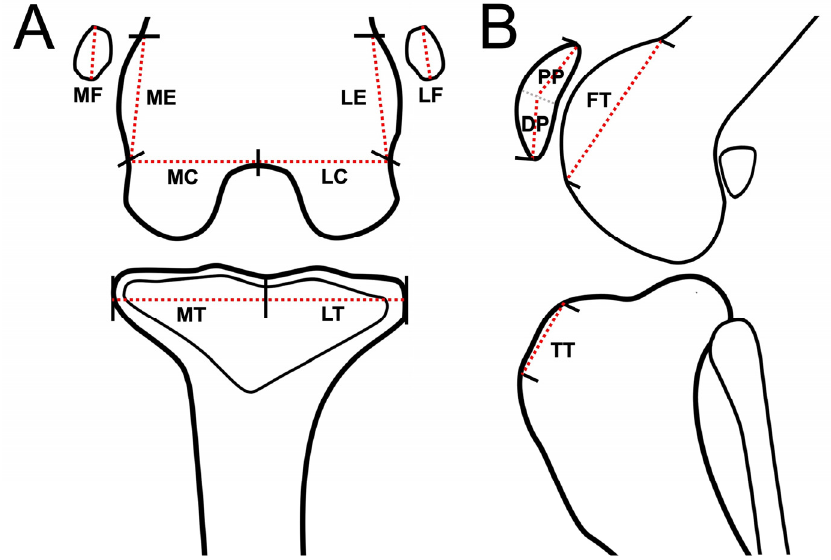
Figure 1. Schematic representation of stifle joint anatomic compartment subregions for evaluation of osteophytes/enthesophytes of each subregion, dorsal plane (MRI and CT) or caudocranial view (DR) ( A ), and sagittal plane (MRI and CT) or lateral view (DR) of stifle joint ( B ). Red dash lines are schematically represented as imaginary anatomic midline (AM) of the stifle joint for each subregion. Stifle joints are divided into 12 subregions for evaluating osteophytes/enthesophytes. Abbreviations: DP: distal patella; FT: femoral trochlear ridges; LC: lateral femoral condyle; LE: lateral femoral epicondyle; LF: lateral fabella; LT: lateral proximal tibia plateau to edge; MC: medial femoral condyle; ME: medial femoral epicondyle; MF: medial fabella; MT: medial proximal tibia plateau to edge; PP: proximal patella; TT: tibial tuberosity.